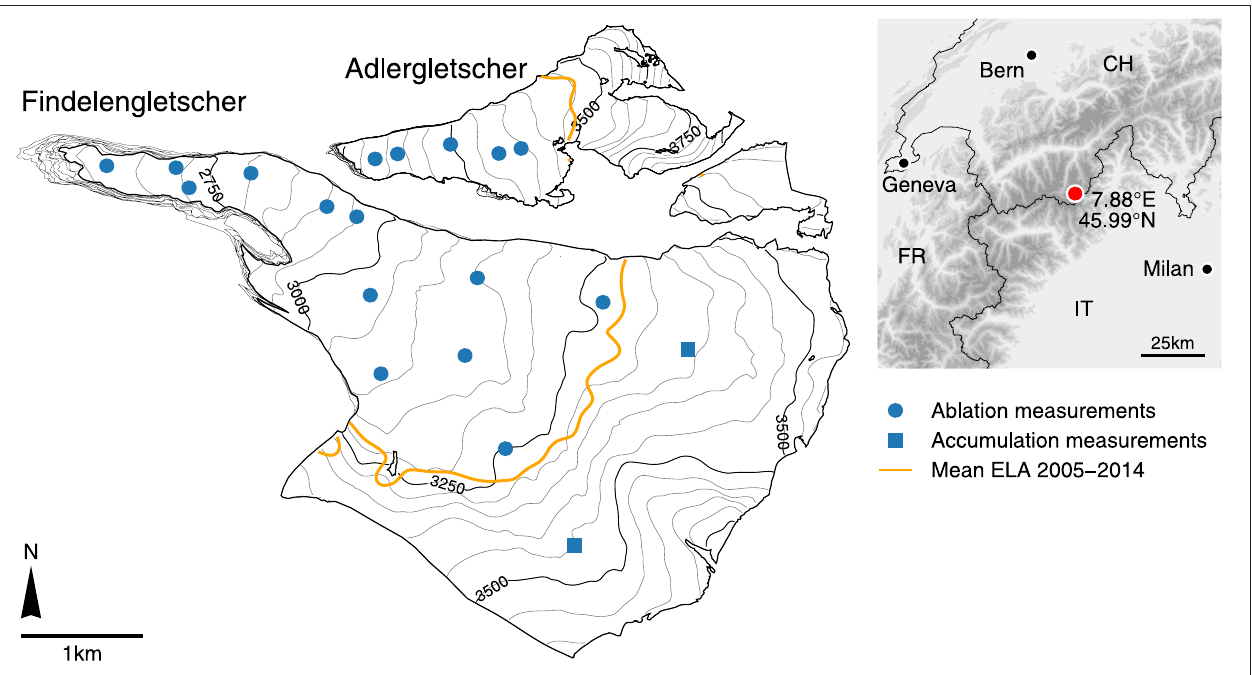
FIGURE 1 | Map of Findelengletscher and Adlergletscher showing the locations of the glaciological mass balance measurements in 2014 as well as the mean equilibrium line altitude (ELA) and the annual glacier outlines for the period studied.